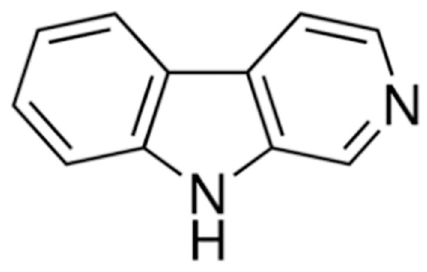
Figure 1. Norharmane chemical structure.